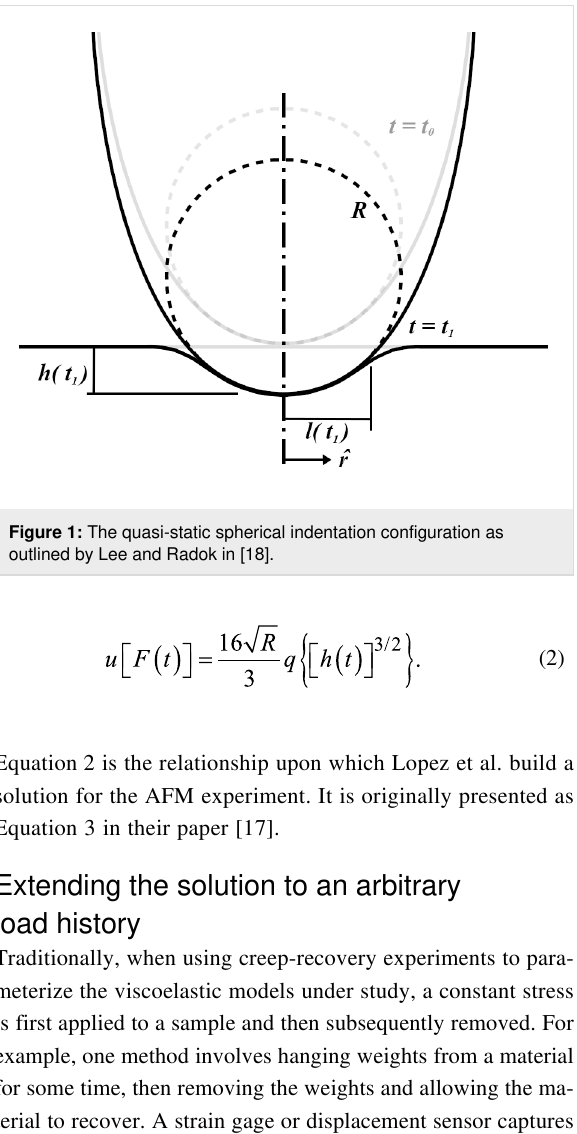
Equation 2 is the relationship upon which Lopez et al. build a solution for the AFM experiment. It is originally presented as Equation 3 in their paper